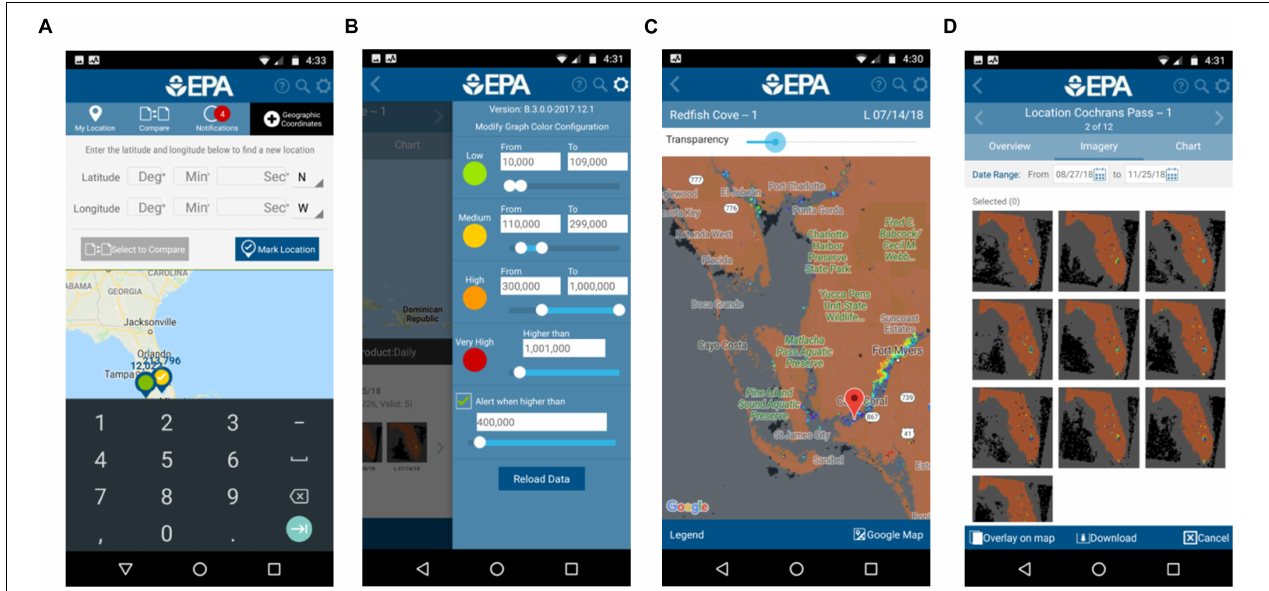
FIGURE 1 | Screenshots of CyAN mobile app (Schaeffer et al., 2018): (A) The main page of the app allows for dropping locations of interest pins using latitude and longitude coordinates or by responsive touch on the screen. (B) The user is also able to set pin colour thresholds and an alert icon setting with the cogwheel based on their own criteria. (C) selecting a pin allows the user to visualise the complete satellite tile for the location of interest for spatial patterns, such as demonstrated with a coastal estuary on the west Florida shelf where Google maps is a transparent layer for quick geographic reference. (D) The user can view a temporal series of images related to their pin location and visualise temporal trends amongst different locations, where each line graph is a single pixel (not